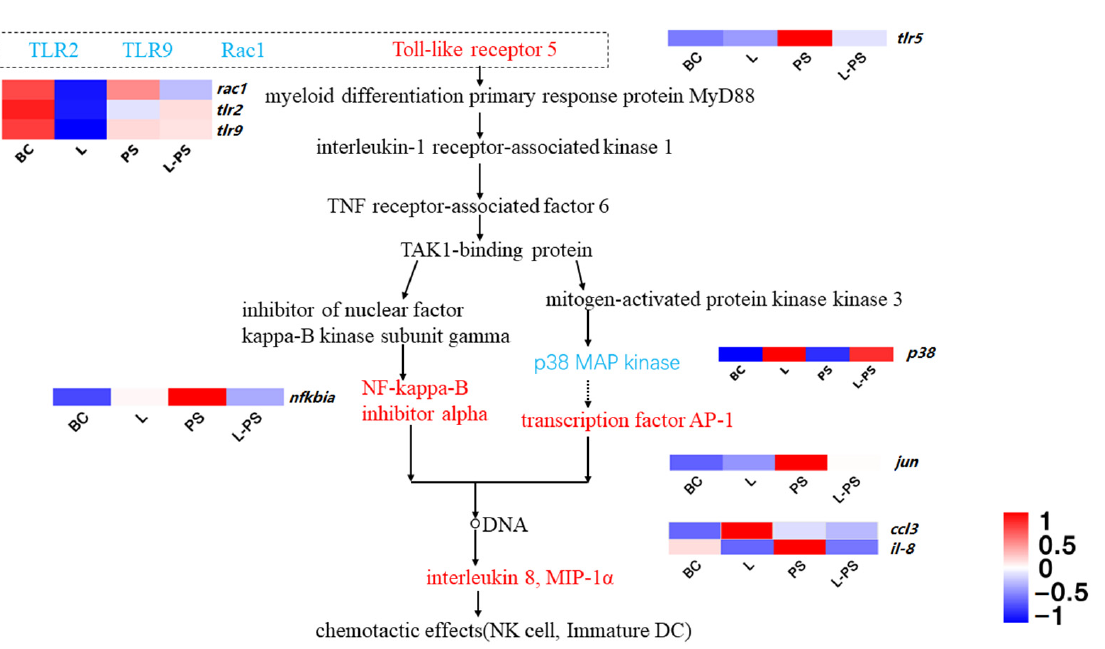
Figure 7. Toll-like receptor signalling pathway.